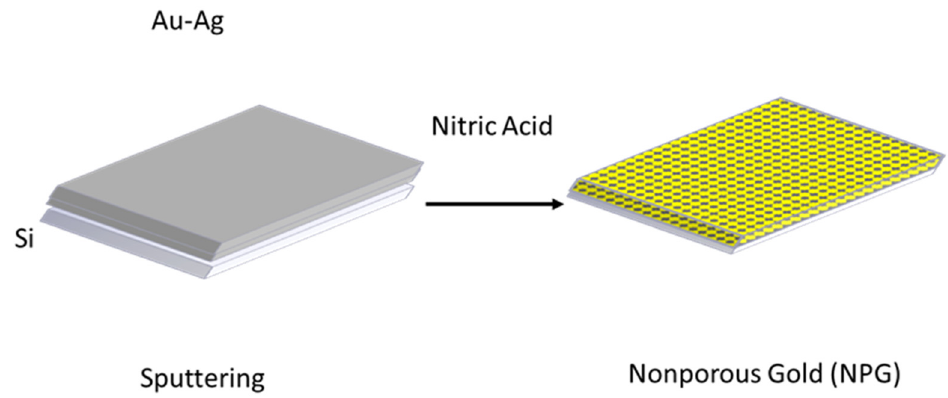
Figure 1. Nanoporous Gold